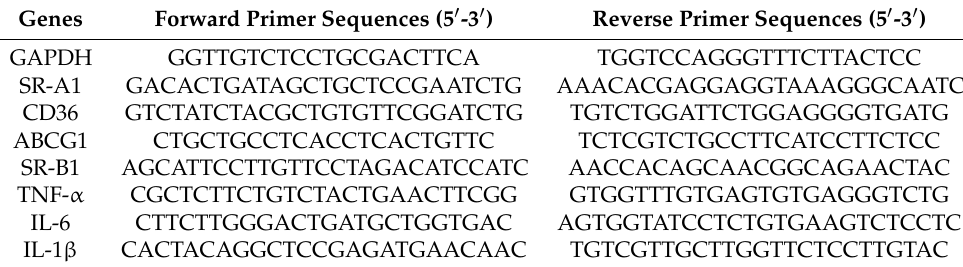
Table 1. The primers sequences of target